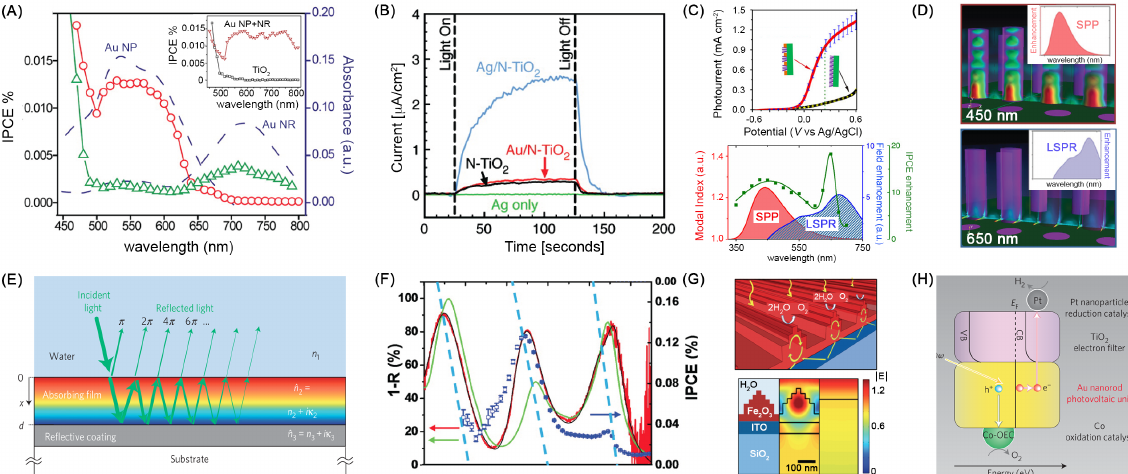
Figure 4: Different approaches to enhance the eflciency of solar water splitting: (A) IPCE plots of TiO 2 modified with both Au NPs and Au NRs. (B) Photocurrent enhancement upon illumination with a broadband light source (400-900 nm) showing the effect of Ag and Au plas- monic enhancement on N-TiO 2 . (C) PEC performance of a α -Fe 2 O 3 nanorod arrays: J–V curves under the illumination of AM 1.5G (top) and IPCE enhancement (bottom). (D) FDTD simulations of an Au nanohole array with α -Fe 2 O 3 nanorods at wavelengths corresponding to: SPP mode that shows the trapping of incident light as waveguided modes in the α -Fe 2 O 3 nanorod (top), and LSPR mode concentrating only on the nanoholes surface. (E) Schematic illustration of the resonant light trapping in a quarter-wave absorbing film on a back-reflector sub- strate. The different colours represent the light intensity distribution across the film (red, high; blue, low). (F) IPCE data (blue dots) together with experimental (red curves) and calculated (green lines) optical spectra for ASM structures with TiO 2 films of thickness 160 nm. (G) Top: schematic view of α -Fe 2 O 3 photoelectrode consisting of a periodic nanobeam-array (brown) on a conductive ITO layer (dark blue) that sup- ports localized Mie and waveguide coupling resonances that boost the absorption of sunlight at the α -Fe 2 O 3 /H 2 O interface. Bottom: re- fractive index (left) and simulated electric field distributions for an optimized nanobeam electrode (center) and a planar, semi-infinite α - Fe 2 O 3 reference electrode (right) for an illumination wavelength of 590 nm. (H) Energy level diagram superimposed on a schematic of an individual unit of the plasmonic solar water splitter, showing the proposed processes occurring in its various parts and in energy space. CB, conduction band; VB, valence band; EF, Fermi energy. Figures (A,B,F,G) adapted with permission from reference [46, 81, 94] and [96], respectively. Copyright (2011-2015) American Chemical Society. Figure (C-D), (E) and (H) adapted with permission from reference [80, 89] and [98], respectively. Copyright (2012-2013) Nature Publishing